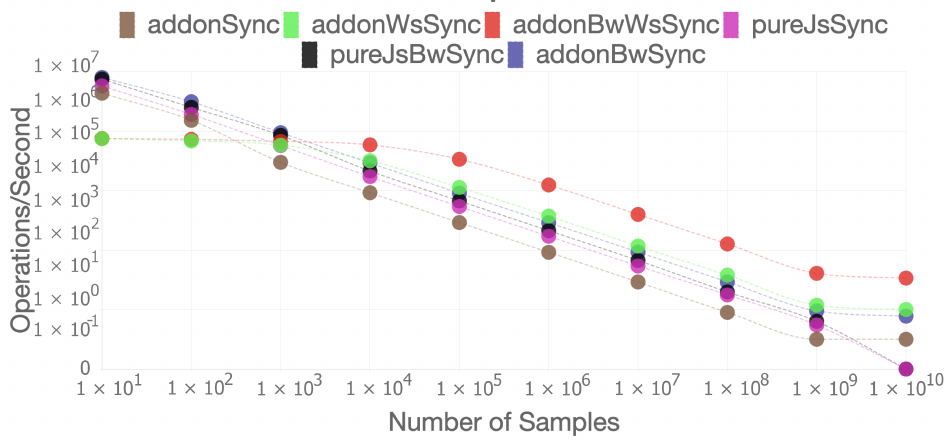
Figure 7. Average operations per second of synchronous implementations in Node.js.